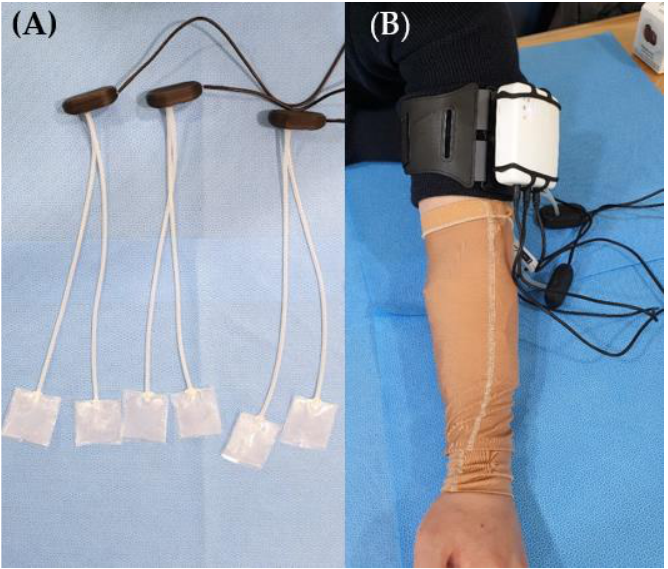
Figure 2. ( A ) Portable pressure-measuring device, sensor; ( B ) pressure garment placement on a patient’s forearm.